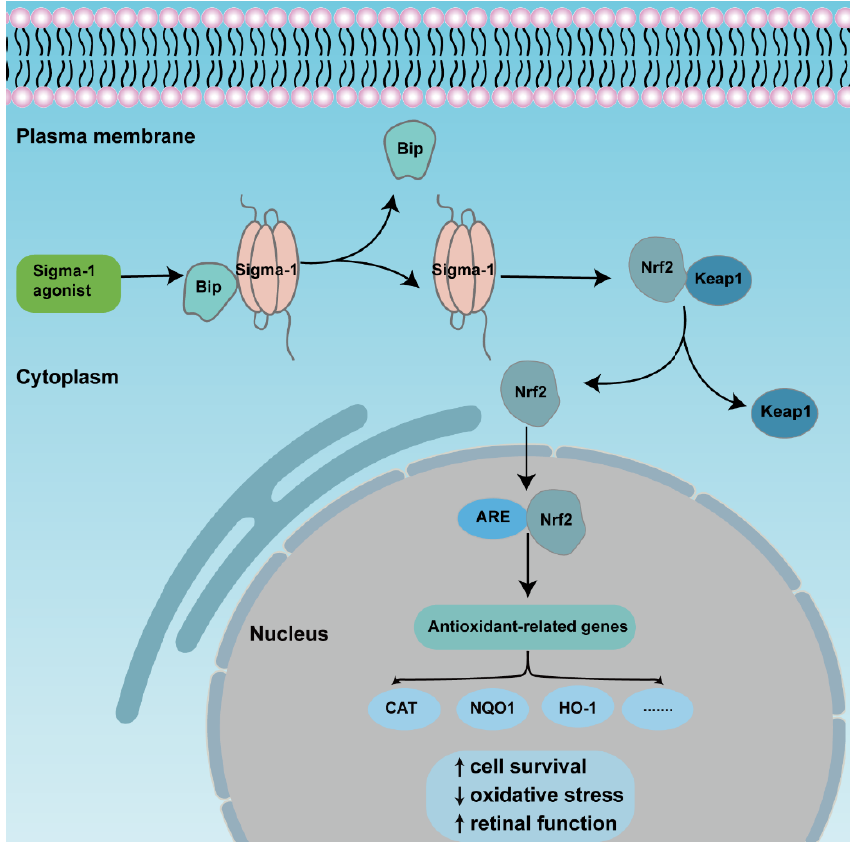
Figure 3. An overview of the mechanism of sigma-1 receptor modulates anti-oxidative function in retina through Nrf2 signaling pathway. The activation of sigma-1 receptor enhances releasing of Nrf2 from combined protein Keap1 and transforms from cytoplasm to nuclei. Nrf2 binds to ARE, then upregulates expression of downstream antioxidant genes., finally promoting cell survival and retinal function.